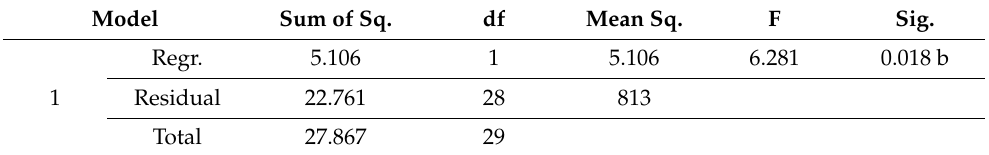
Table 1. E-court system quality and e-court use. Model